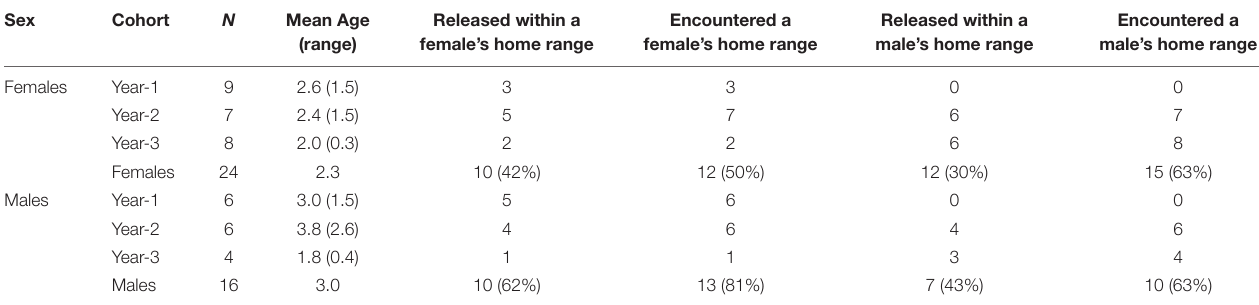
TABLE 1 | The total number of female and male fishers released by cohort, their average ages (range in parentheses), whether fishers were released within the home ranges of a female or male fisher released at least 2 months earlier, and whether released fishers encountered the established home ranges of other fishers while seeking places to establish their own home ranges.